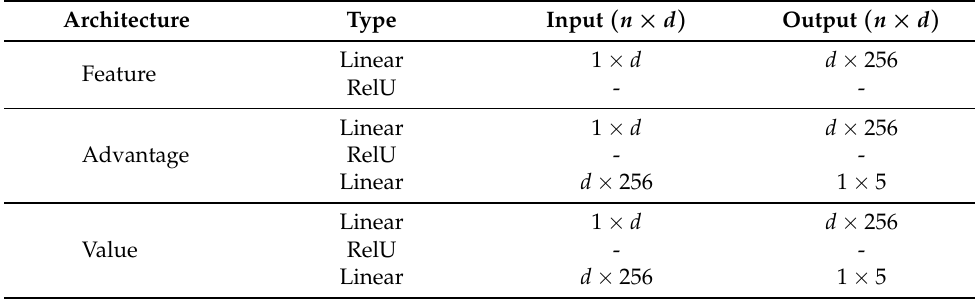
Table 2. Dueling-DQN architecture for Dataset Base and Dataset Equipment